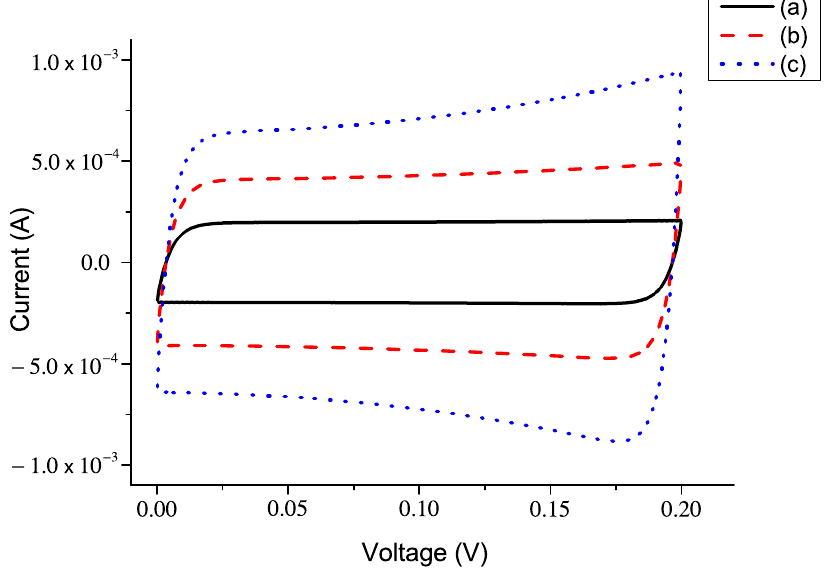
Figure 5. Parametric curves I ( V ) for an electrolytic cell with identical electrodes, with the same adsorption properties with respect to positive and negative ions. The adsorption coefficients are 10 − 6 m/s and the desorption times are 1 s. The screening parameters are 0.04 (a), 0.08 (b), and 0.12 (c).